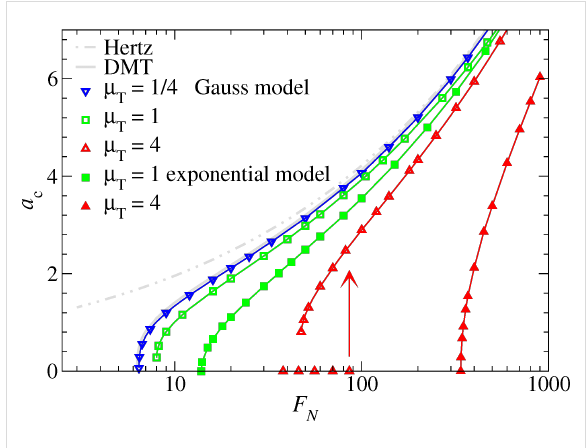
Figure 16: Contact radius a c as a function of normal force F N for the exponential (full symbols) and the Gauss (open symbols) model. Lines connect data points (not all shown explicitly). In the case of μ T = 4 (Gauss model), an arrow indicates where the a c = 0 solution becomes unstable for increasing F N . Color coding: μ T = 4 (red), μ T = 1 (green), and μ T = 1/4 (blue).